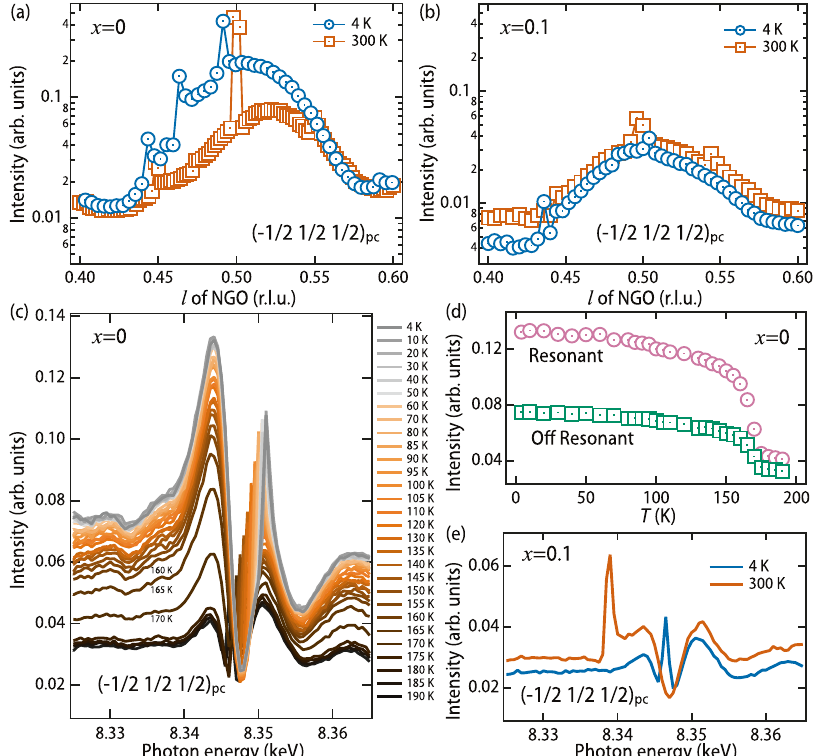
Fig. 4 Temperature dependent resonant X-ray scattering. l -scan through the ( − 1/2 1/2 1/2) pc [(0 1 1) or , or and pc denote orthorhombic and pseudo-cubic setting, respectively] re fl ection for ( a ) x = 0 and ( b ) x = 0.1 thin fi lms at 4 K and 300 K, recorded with photon energy 8.33 eV. The variation of the ( − 1/2 1/ 2 1/2) pc re fl ection of the x = 0 thin fi lm around Ni K -edge at various temperatures for ( c ) x = 0 and ( e ) x = 0.1 thin fi lms. Temperature dependent resonant and off-resonant intensities ( I res and I offres ) of the corresponding scan of x = 0 fi lm are plotted in d . The spikes in a , b , c , and e arise due to multiple waves